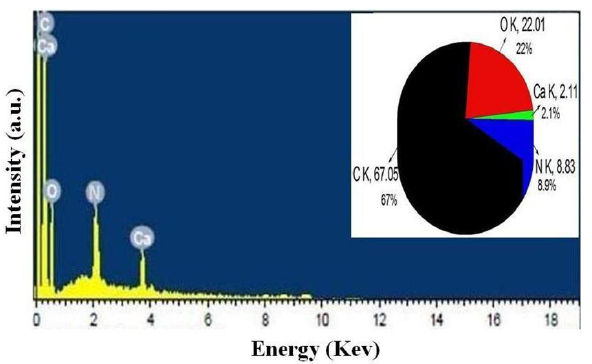
Fig. 4. Energy-dispersive x-ray (EDS) spectra of PA66/CaCO